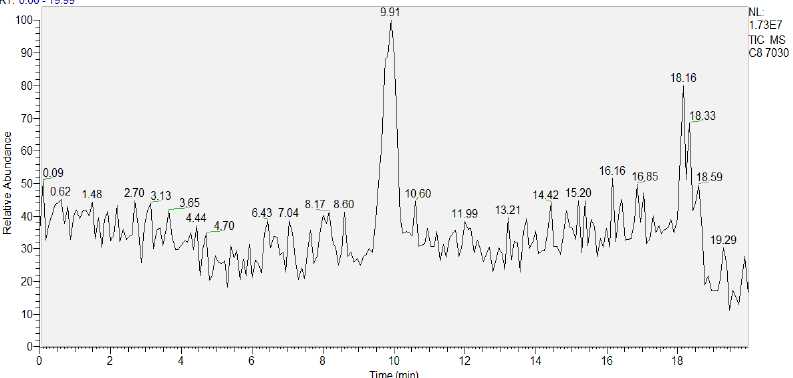
Figure 2. The EIC of ox-PAPC product m / z = 846.5. Ox-PAPC was prepared by in vitro oxidation (FeCl 2 : H 2 O 2 = 2:1) of 100 µg/mL native PAPC standard at 37 °C for 15 min. The selected stationary phase was a C 8 column. The selected mobile phase contained 70% acetonitrile, 30% isopropanol, and 0.1% formic acid.